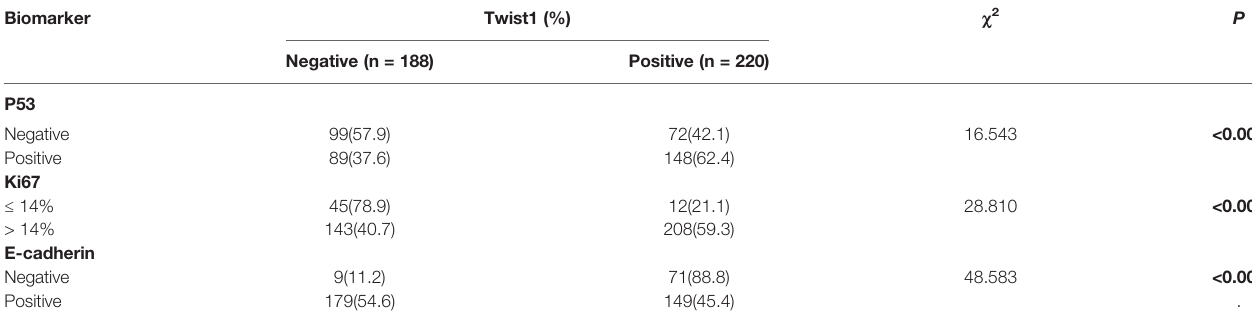
TABLE 2 | Association between Twist1 expression and other molecules in breast cancer patients.